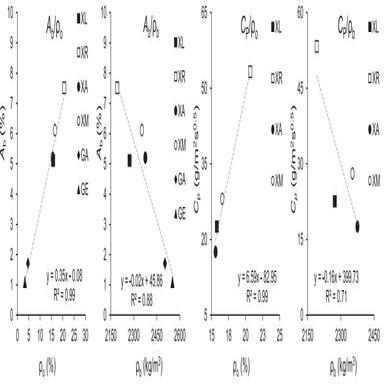
Linear correlations for water absorption (Ab and C) and physical parameters (qo and qb).